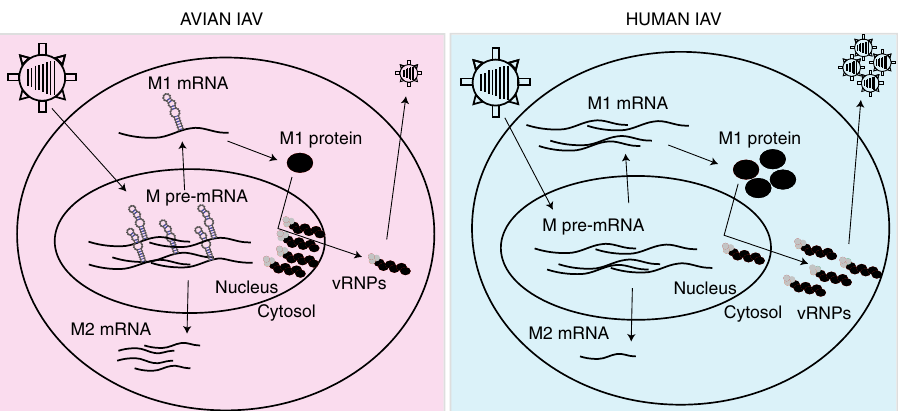
Fig. 7 Hypothetical model for the role of M segment splicing for IAV host range. A cis -regulatory secondary structure element (indicated hairpins) in avian but not human IAV M pre-mRNA facilitates splicing. This leads to the underproduction of M1 mRNA and protein in human cells infected with avian- adapted IAVs. The poor availability of the M1 protein may contribute to an impaired nuclear export of viral